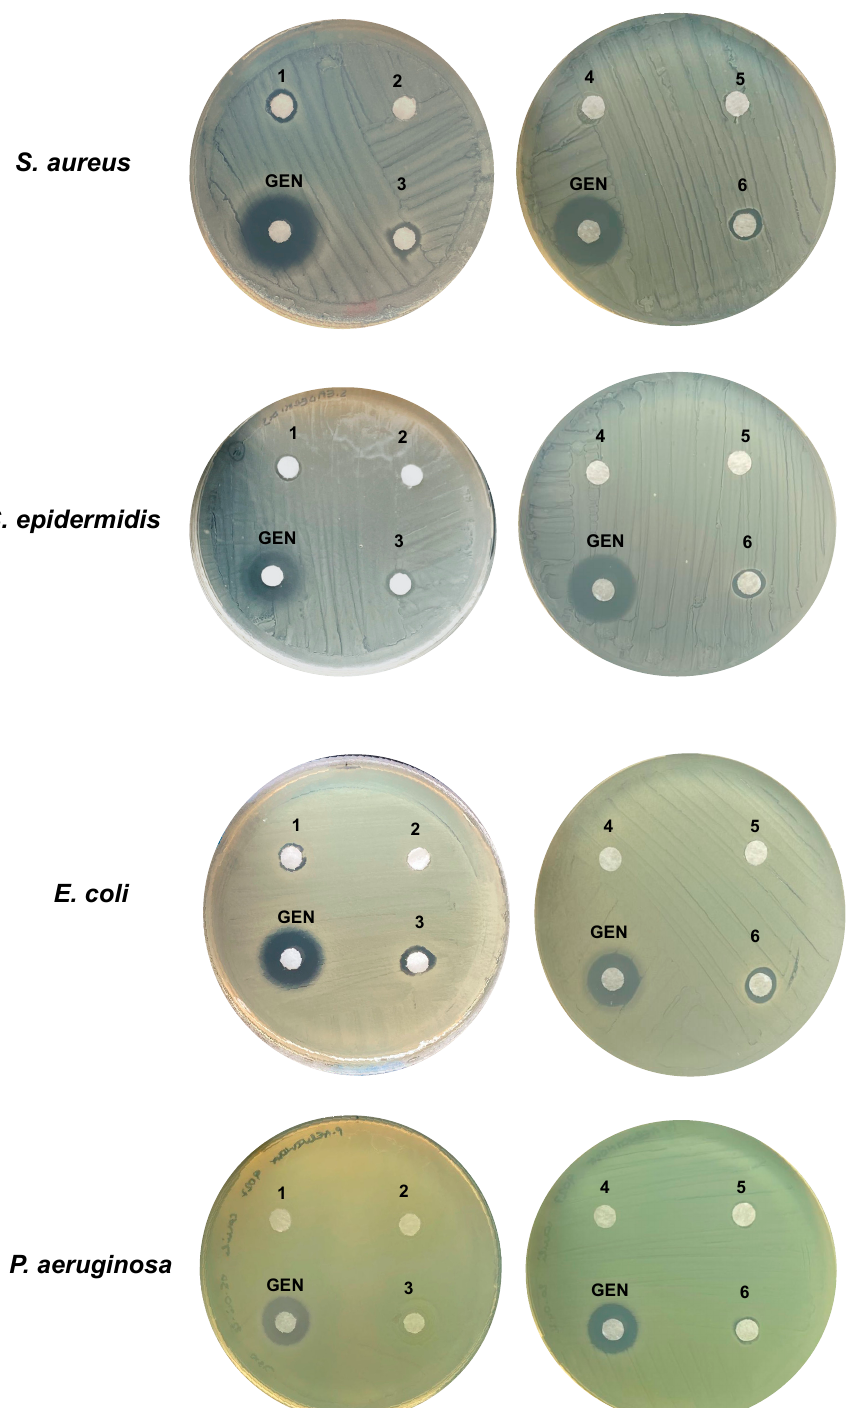
Figure 1. Disk diffusion assay . The following ophthalmic formulations were spotted onto agar plates containing the tested microorganism, and the antimicrobial effect was evaluated as inhibition growth zone: 10 µ L of Iodim ( 1 ), Ozodrop ( 2 ), Dropsept ( 3 ), PVA ( 4 ), thymol ( 5 ), and PVA + thymol ( 6 ) solutions were assayed respectively for their inhibitory activity over the growth of S. aureus , S. epidermidis , E. coli , and P. aeruginosa . Geneticin (GEN) was used as positive control. Representative images of three independent assays were performed in separated days. Table 5. Schematic results of disk diffusion assay.